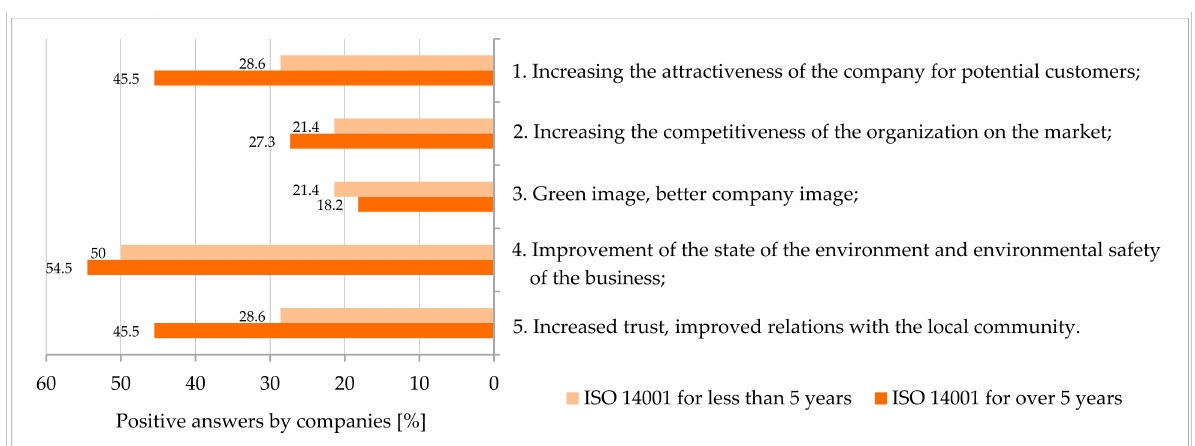
Figure 8. Analysis of the external benefits resulting from the implementation of EMAS depending on the duration of the system operation in organizations.